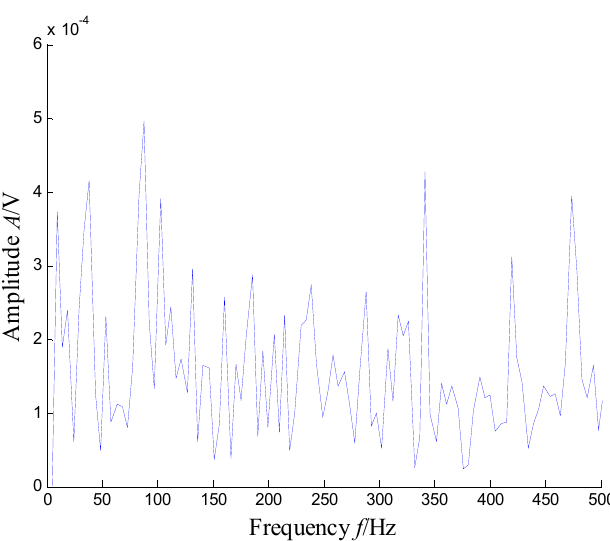
Figure 18. Envelope spectrum of the extracted signal.